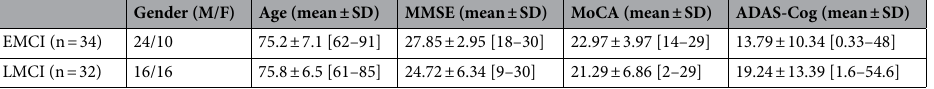
Table 1. Demographic and neuropsychological Information from ADNI-3 dataset. MMSE Mini-mental State Examination, MoCA Montreal Cognitive Assessment, ADAS-Cog AD Assesment Scale-Cognitive Scale, SD standard deviation